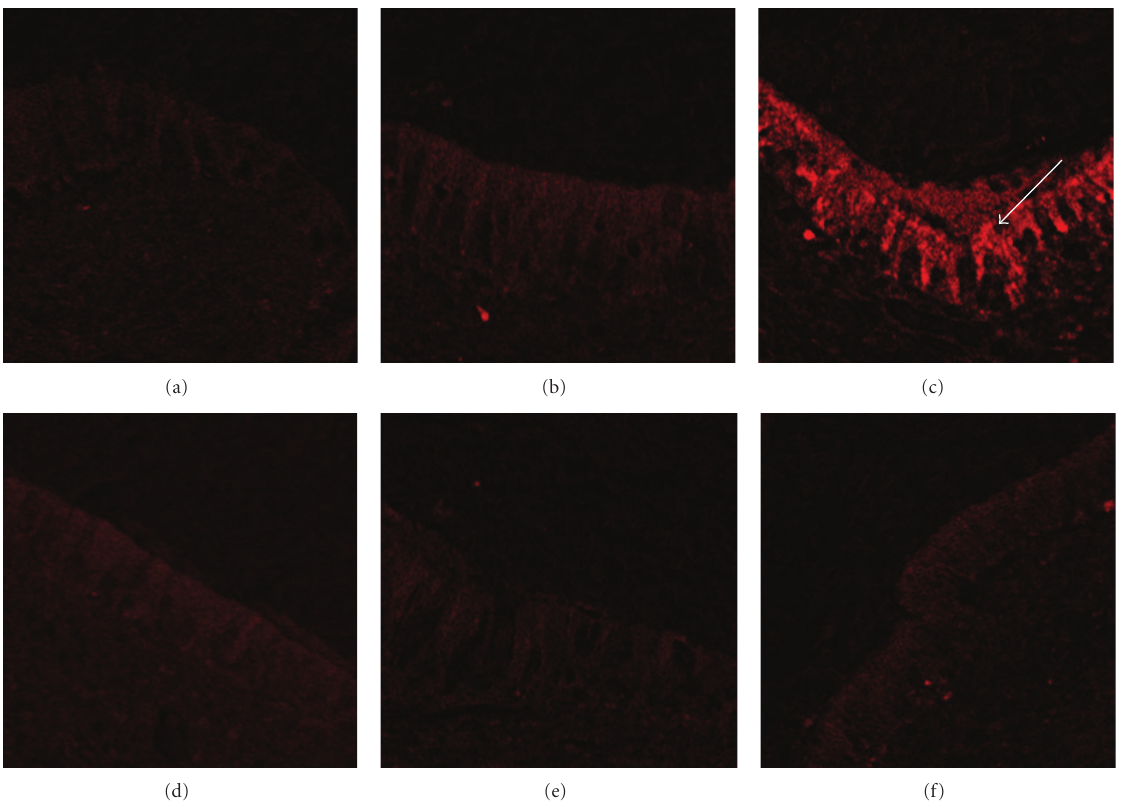
Figure 1: Fluorescence microscope images of Evans blue dye leakage on the 4th day. (a) Normal group; (b) saline group; (c) LPS group; (d) sTNFRI group; (e) antibiotic group; (f) sTNFRI/antibiotic group. Massive leakage of Evans blue dye was observed in the mucosa of the LPS group ((c), arrows) ( ×